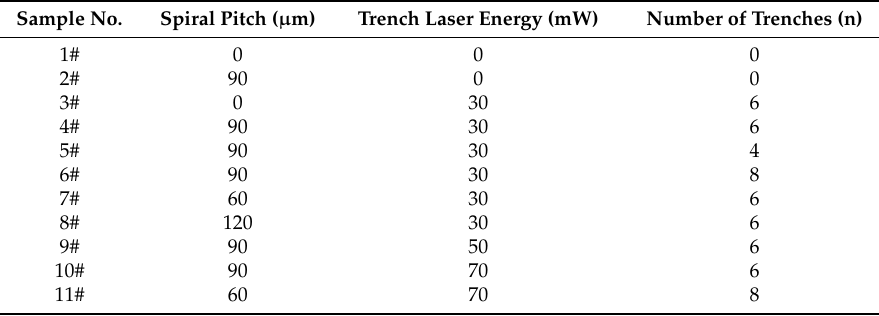
Table 2. The sample